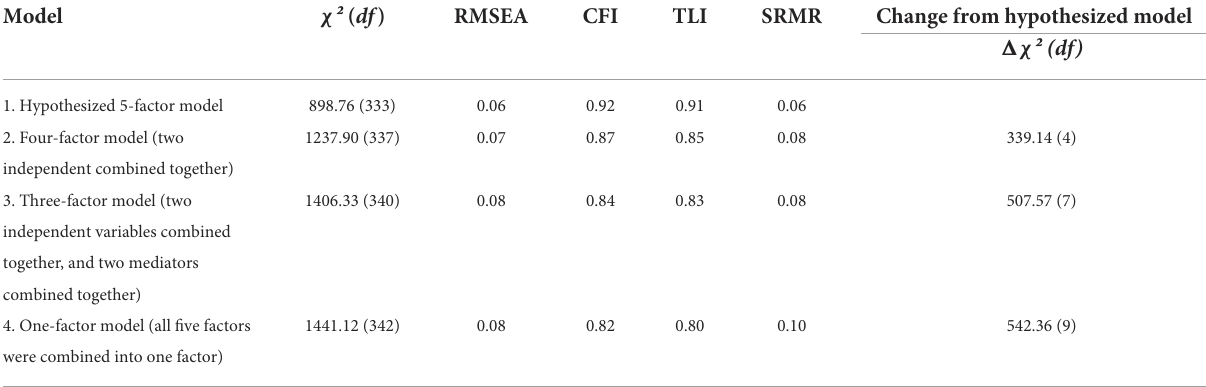
TABLE 1 Results of the confirmatory factor analyses ( N = 511). Model